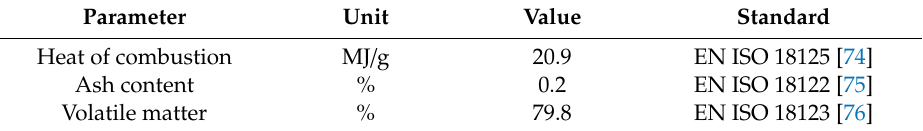
Table 2. Characterization of raw material—all values refer to the dry state of